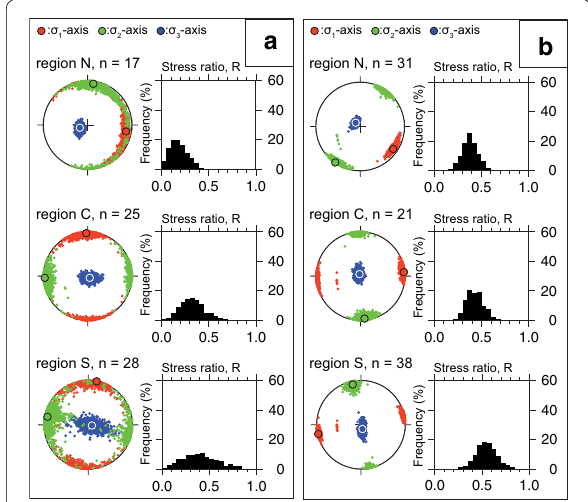
Fig. 3 Results of stress tensor inversion in regions N, C, and S for a the period before (11 March 2011 to 3 June 2002) and b the period after (11 March 2011 to 31 December 2017) the Tohoku earthquake. The locations of these regions are shown in Fig. 1b. The left panel shows stress tensor inversion results. Red, green, and blue dots correspond to the 95% confidence regions of the σ 1 , σ 2 , and σ 3 axes, respectively, and red, green, and blue circles correspond to the best-fit solutions of the same axes, respectively. The right panel shows the frequency distributions of stress ratio R , where R ( σ 1 σ 3 ), for the respective −